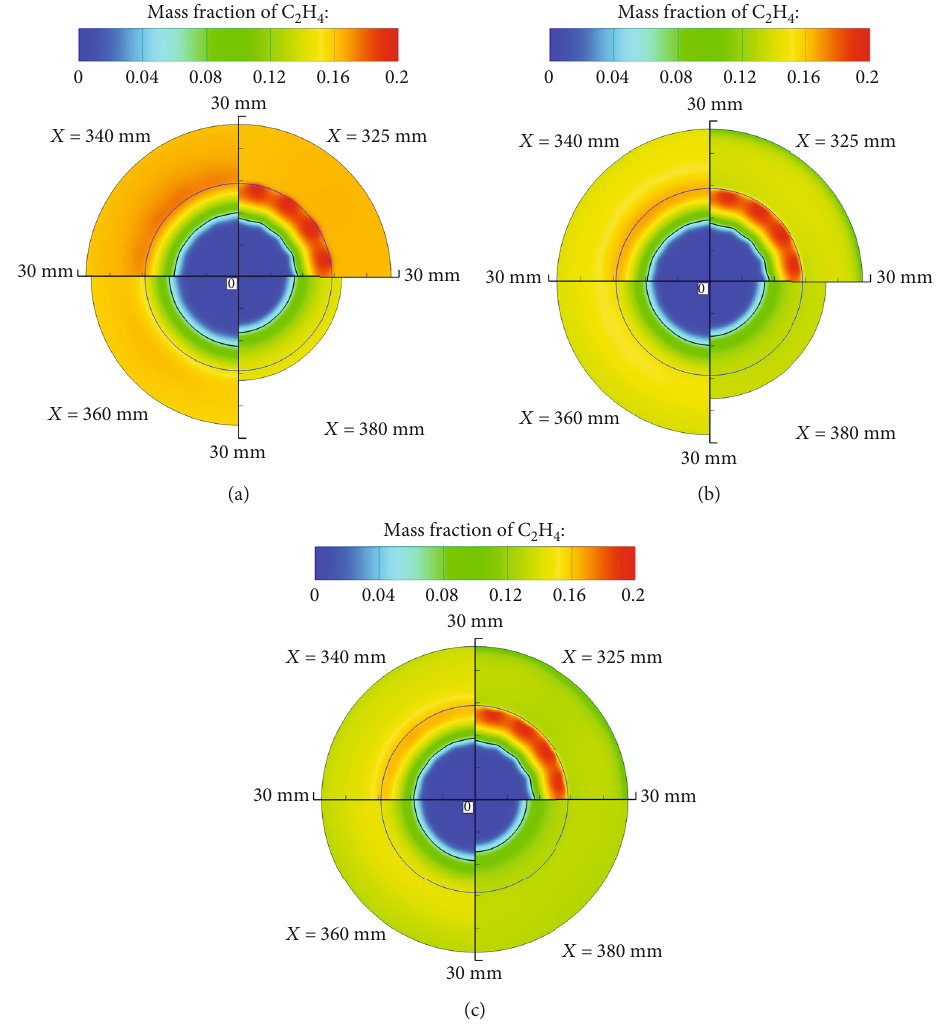
Figure 9: X -direction slices of mass fraction of C isoline of the appropriate equivalence ratio and the lip line of the cavity,